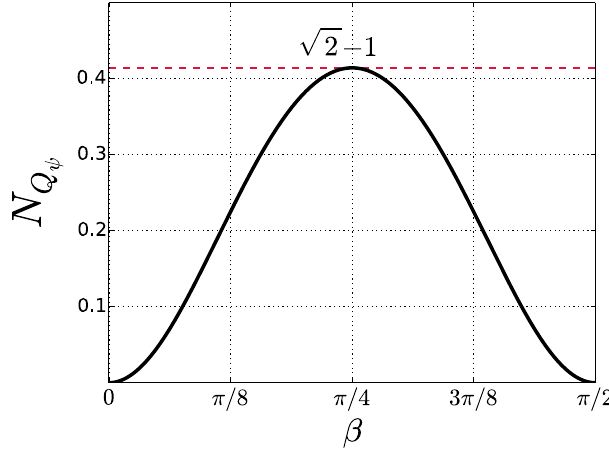
Figure 1. Maximal